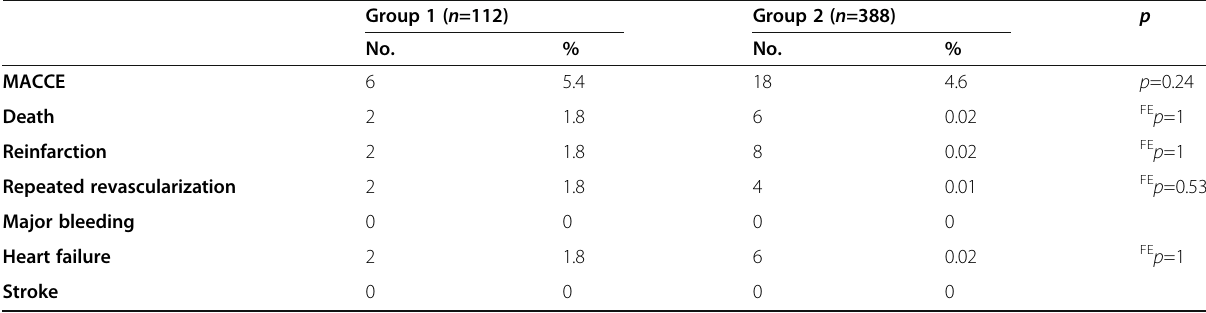
Table 6 Six months follow-up outcomes of the studied